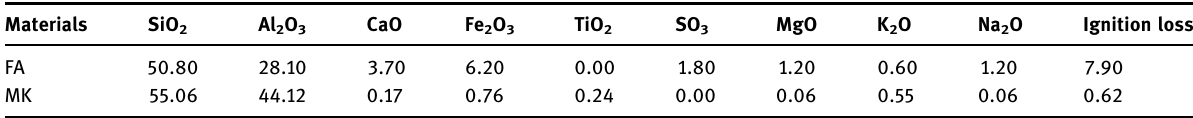
Table 1: Chemical composition table of FA and MK